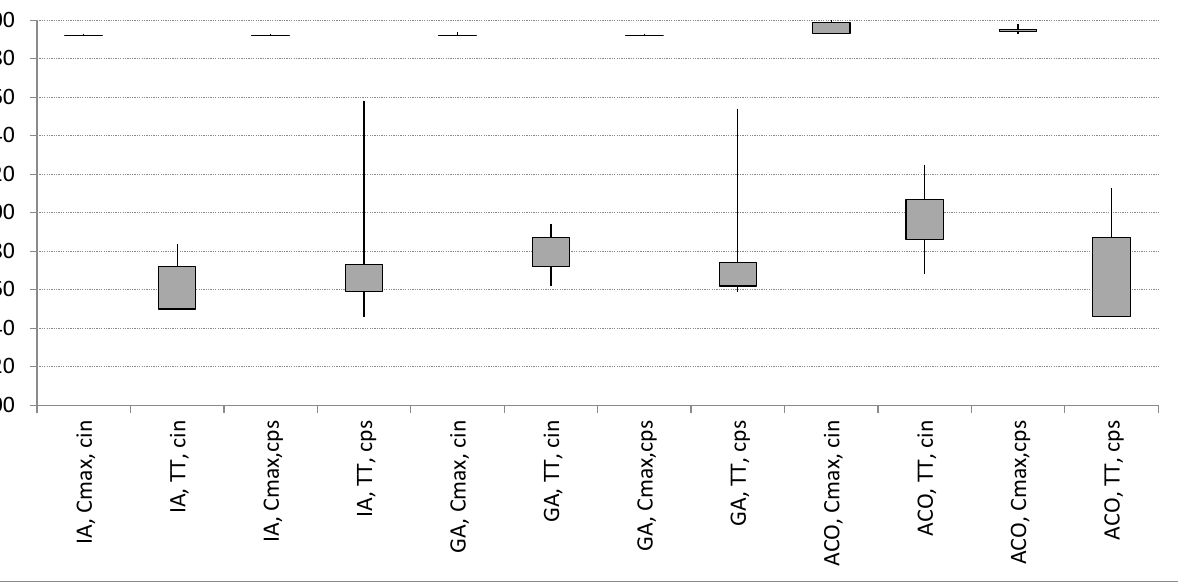
Figure 8. Parameters of MTTF and MTTR estimation for the FlexSim simulation: ( a ) ˆ p i + 1 ; ( b ) ˆ λ i ; ( c ) ˆ α i + 1 with the polynomial trend function; ( d ) ˆ α i + 1 with the linear trend function. Mean Time of Repair MTTR is described by the exponential distribution (11). Param-